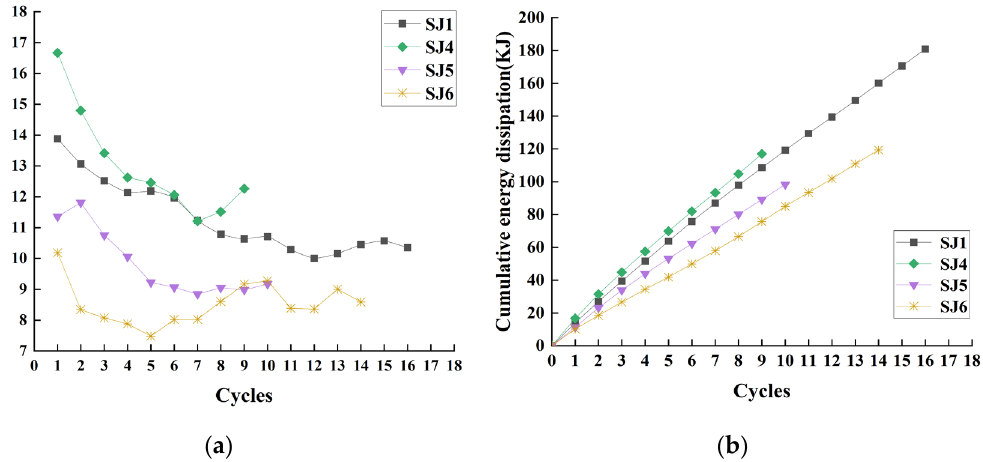
Figure 11. The energy dissipation analysis of SJ1, SJ4, SJ5, and SJ6: ( a ) Energy dissipation; ( b ) Cumulative energy dissipation.